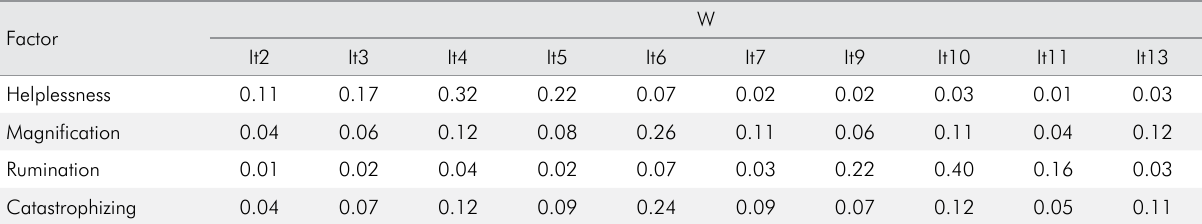
Table 5. Weights (W) obtained from the regression matrix attributed to items on the Pain Catastrophizing Scale (PCS) to compute the global score of the “Helplessness”, “Magnification”, “Rumination”, and “Catastrophizing” factors.